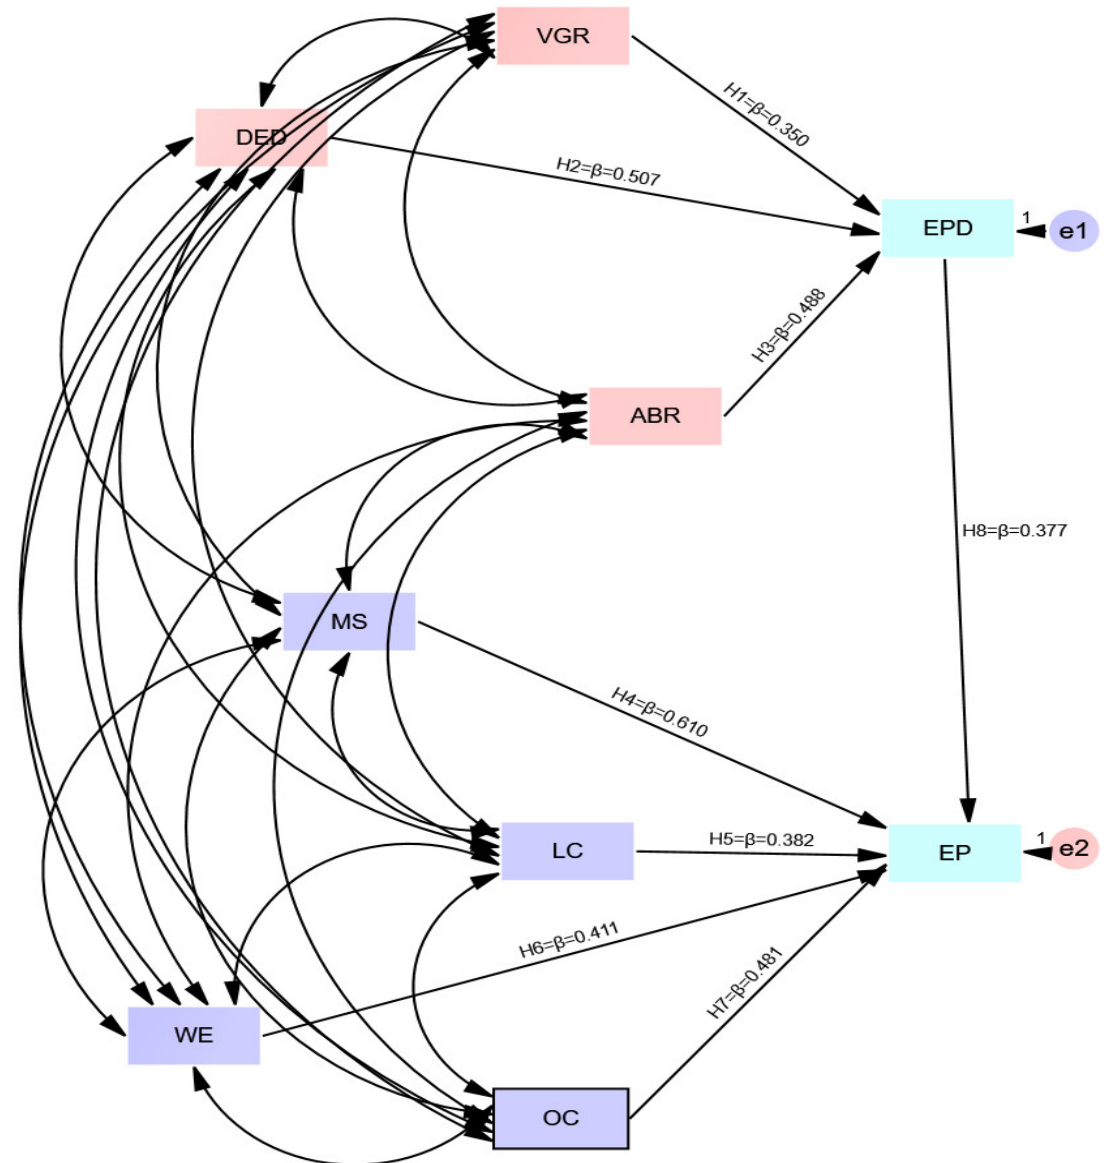
Figure 2. SEM analysis. Note(s): VGR, vigour; DED, dedication; ABR, absorption; MS, management support; LC, learning culture, WE, work environment; OC, organizational commitment; EPD, employee productivity; EP, employee performance.